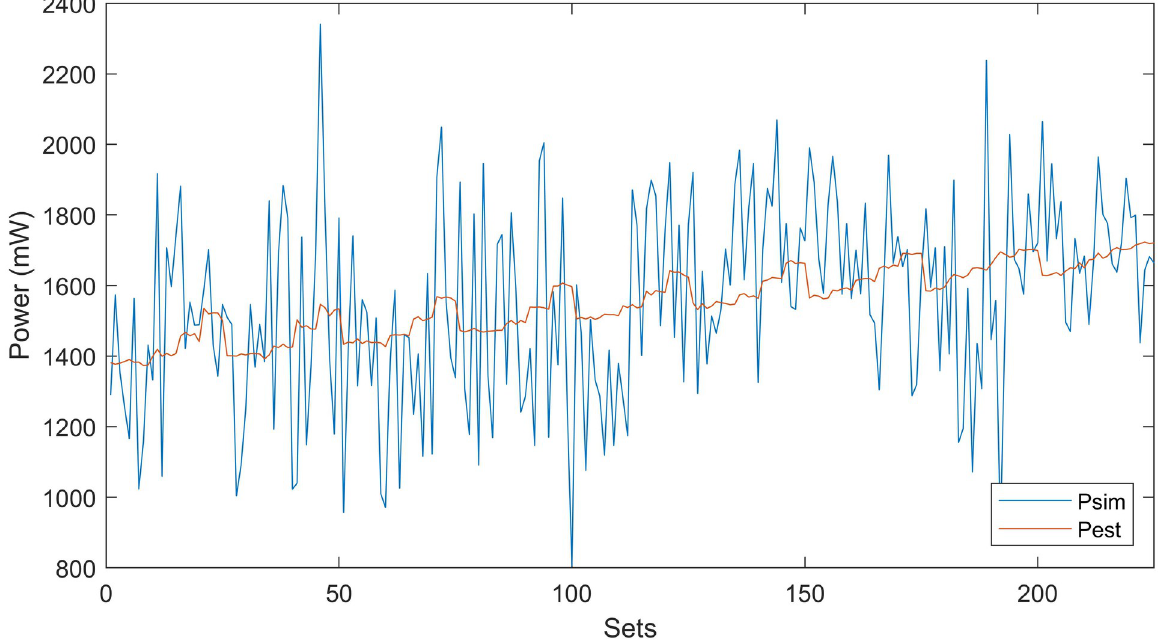
Fig 9. Correlation between simulated and estimated powers for heterogeneous 3D IC.